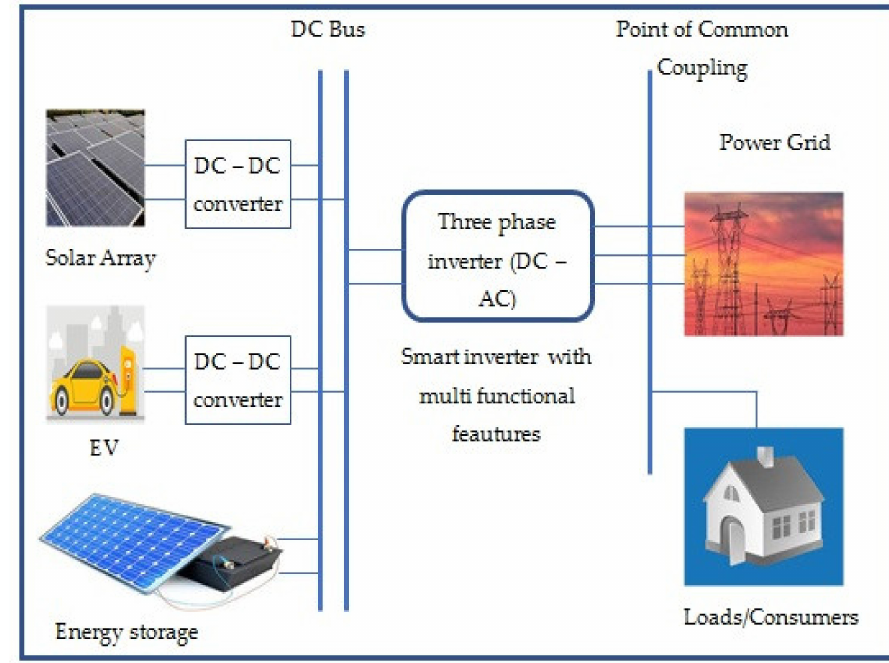
Figure 2. Smart inverter with multi-functional